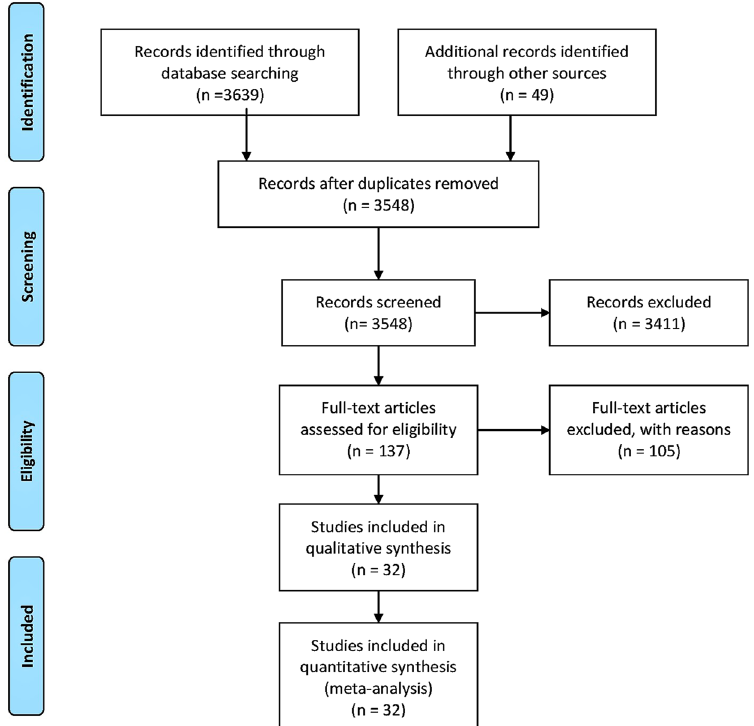
Figure 1. A flowchart of the study screening and selection